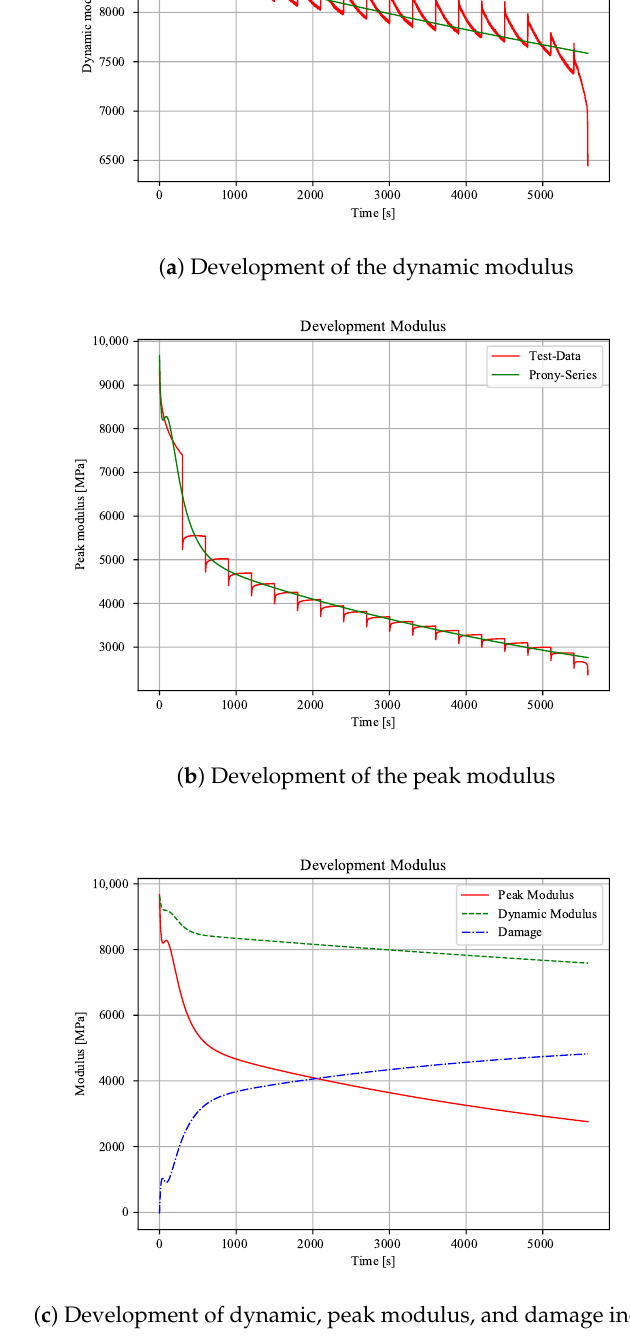
Figure 10. Development of moduli with cyclic load including static load blocks (stress amplitude 0.3, 75% constant load at maximum load